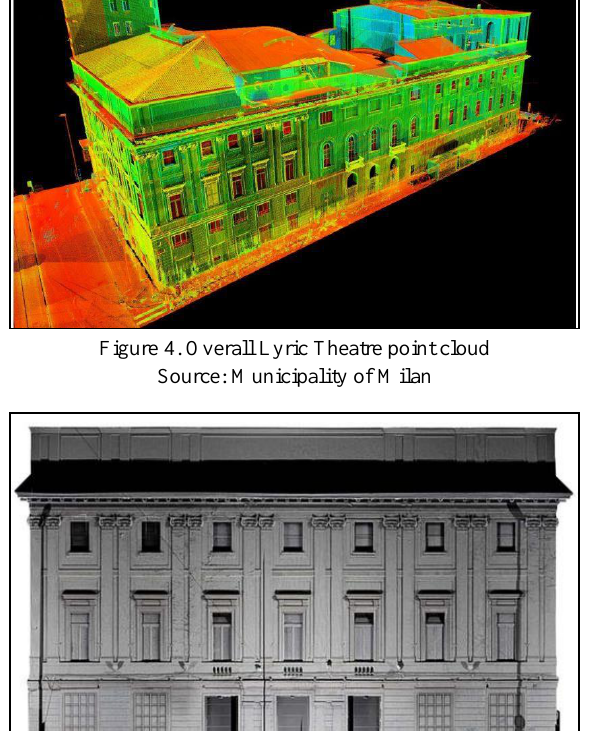
3. SECOND PHASE: 3D MODEL